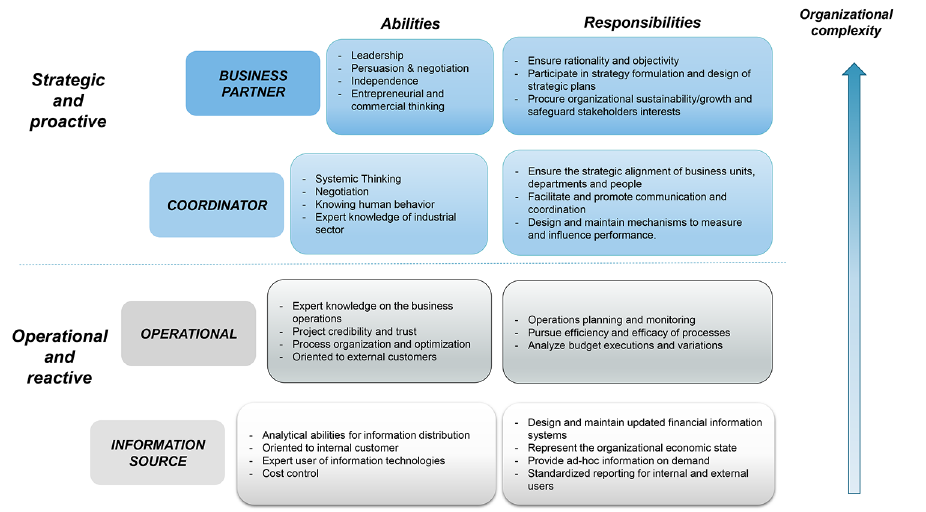
Figure 1. Conceptual framework for the controller